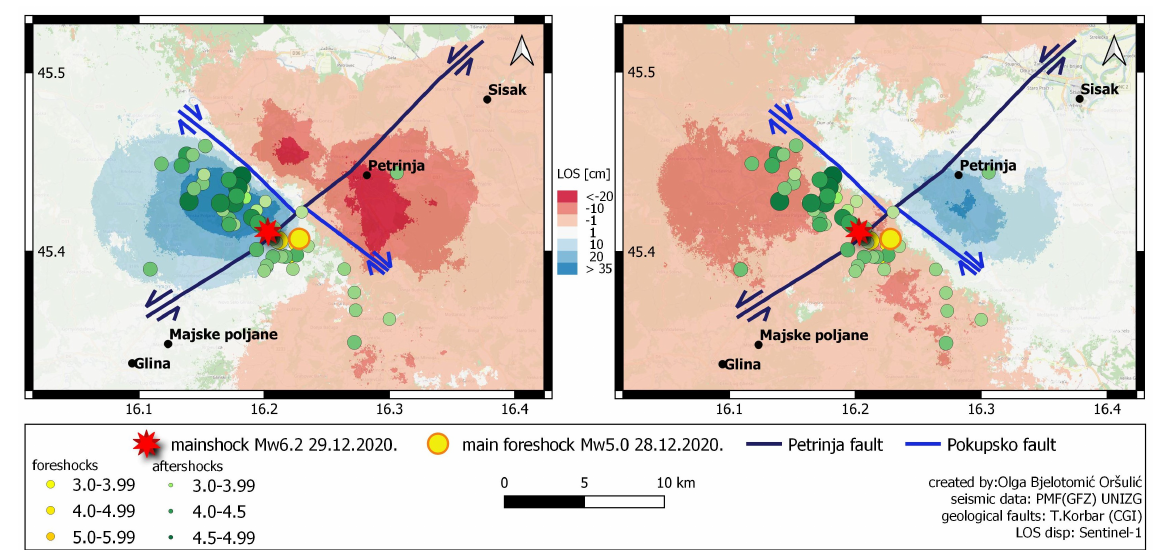
Figure 6. Figure shows LOS displacement over earthquake area in NW Croatia: ascending orbit of Sentinel-1A ( left ) and descending orbit of Sentinel-1B satellite ( right )